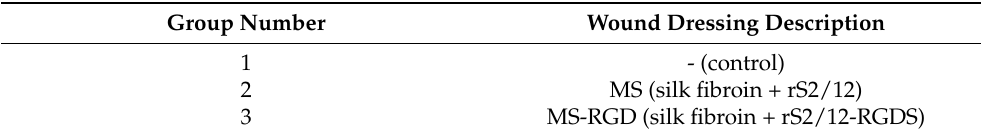
Table 1. Experimental groups with 5 animals in each group. Group